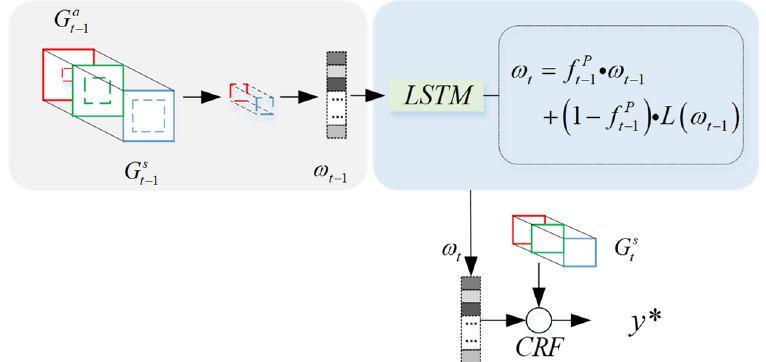
Figure 5. The input feature fusion